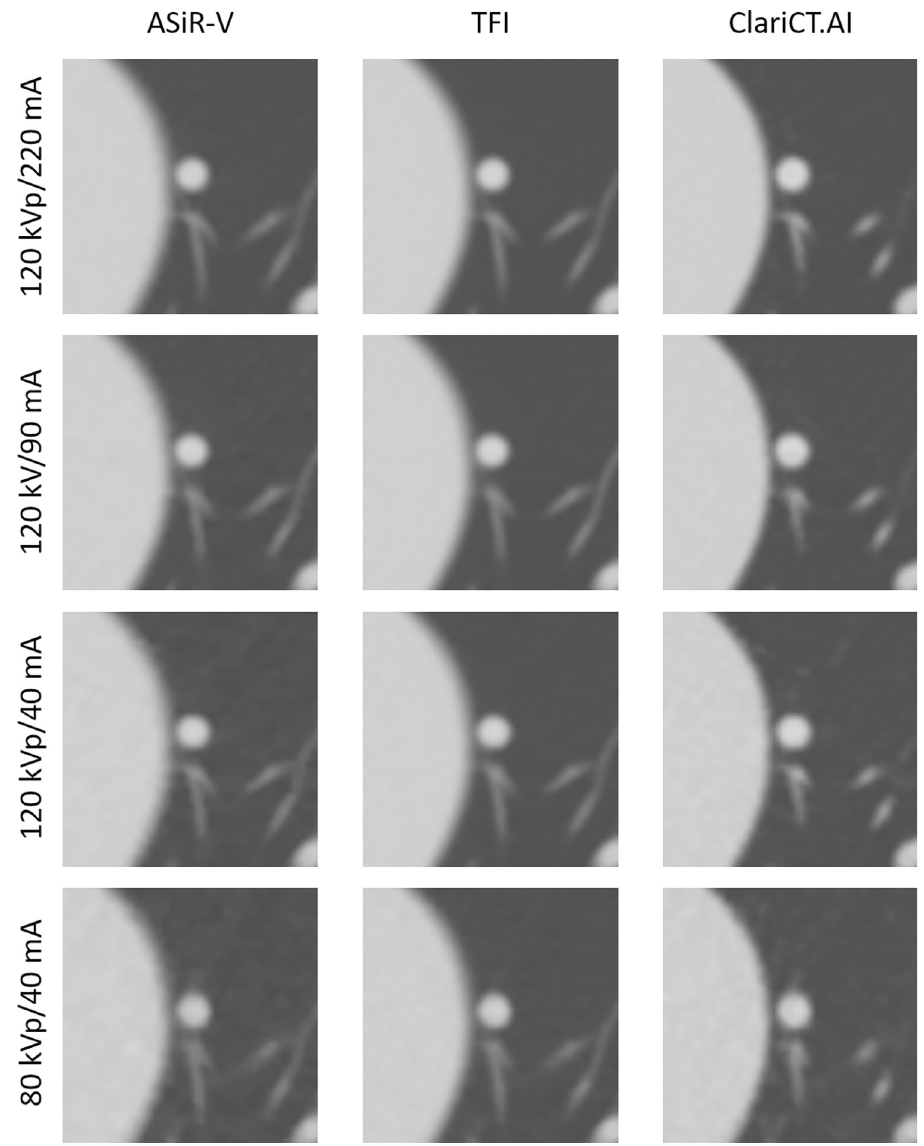
Fig 1. CT images of SNs at different radiation dose settings. Images of SNs (5 mm) at four radiation dose settings reconstructed with ASiR-V, TFI, and ClariCT.AI.